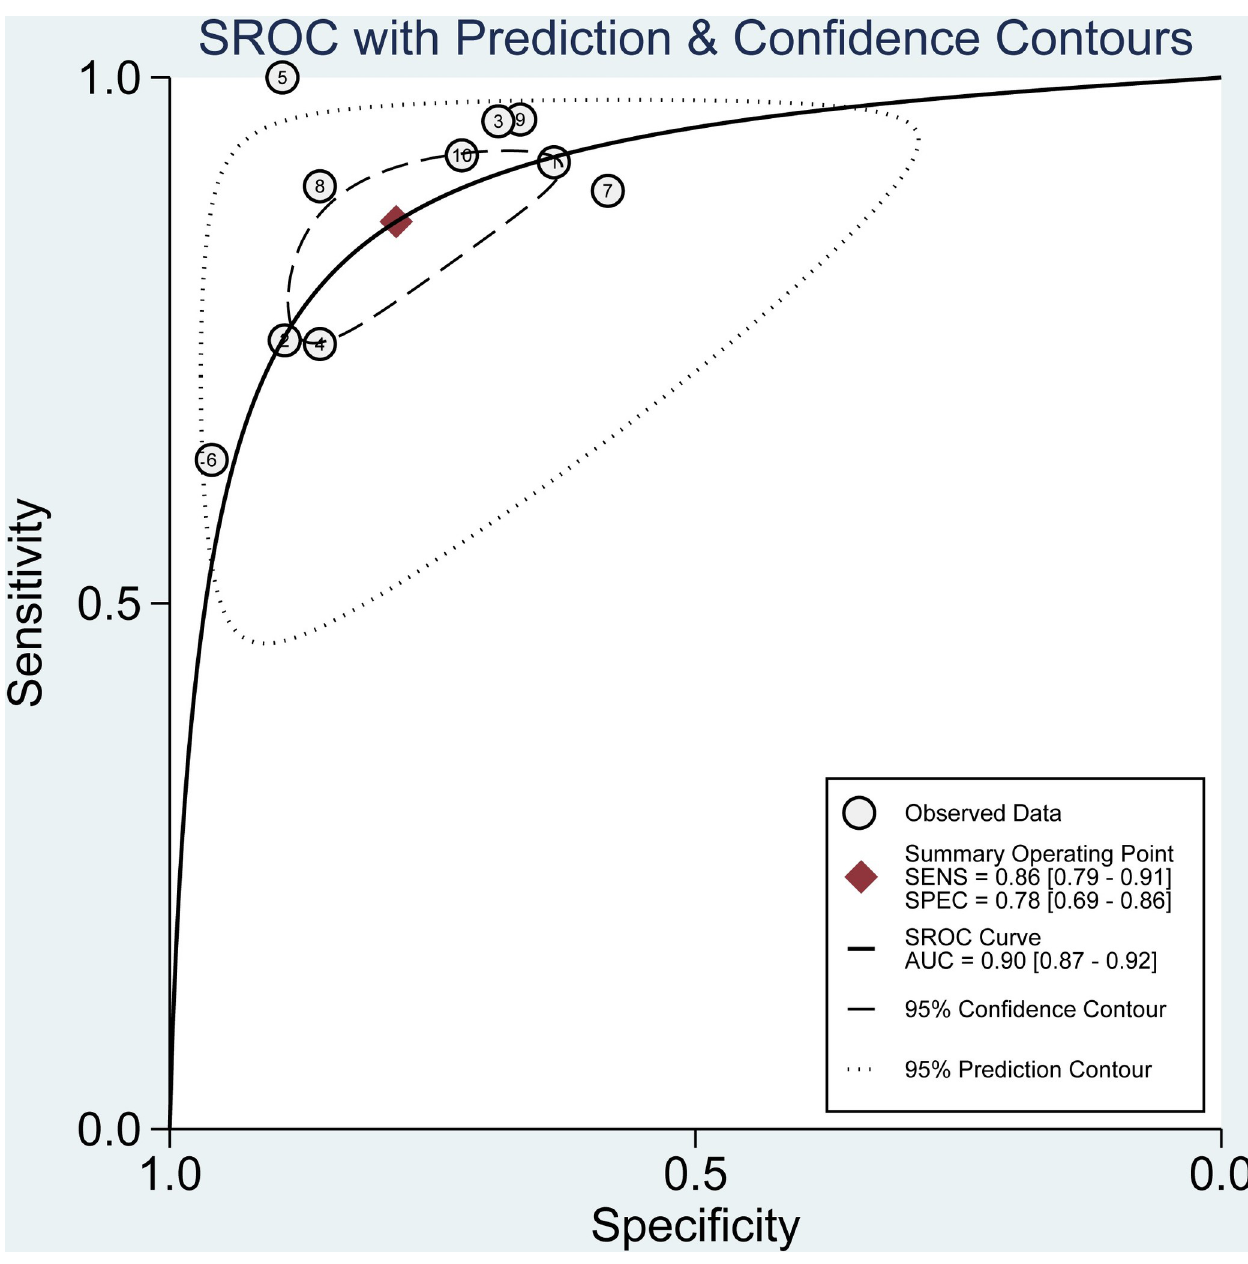
Fig 3. Summary ROC curve for the 6 included studies. Numbers in brackets are 95% CIs. ROC: receiver operating characteristic, AUC: area under curve, SENS: sensitivity, SPEC: specificity, CI: confidence interval.